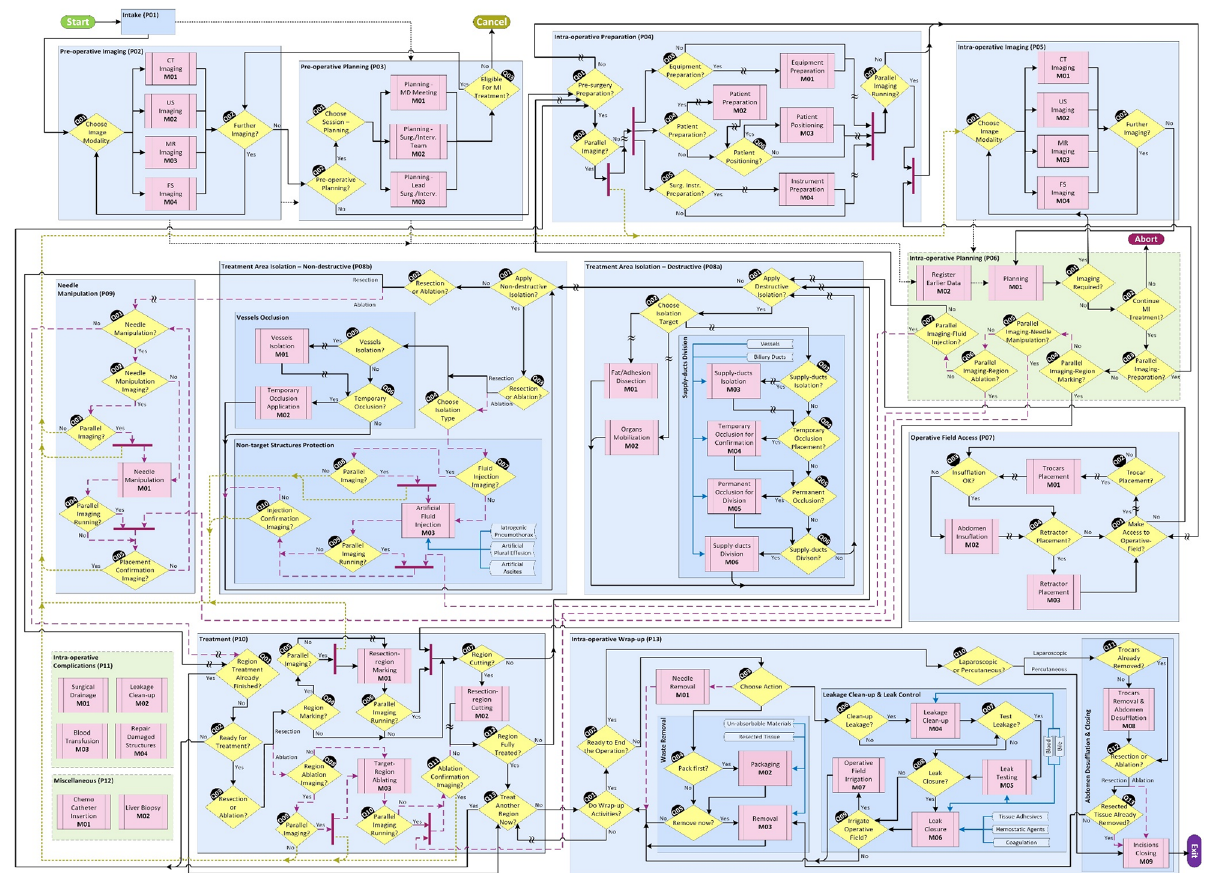
Figure 4. Generic process model for MILT procedures at the module granularity level. See Fig. 5 for explanation of the used symbols and line styles. DOI: https:// doi. org/ 10. 4121/ 20163